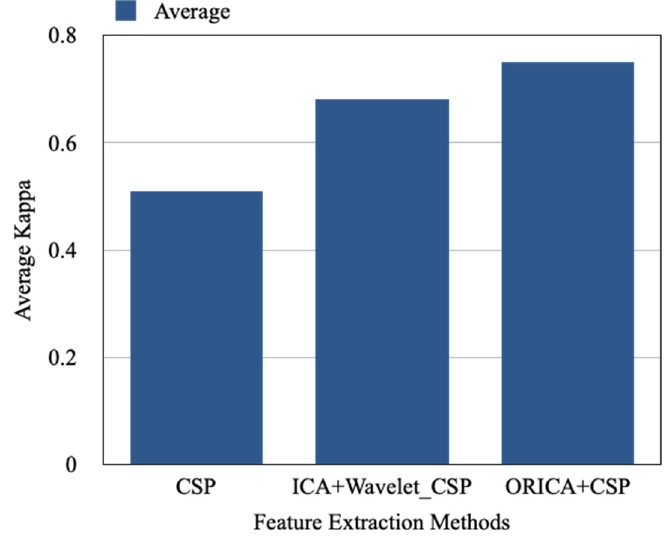
Figure 9. Comparison of average kappa value with CSP, ICA + Wavelet-CSP, and ORICA + CSP. Table 2. Performance comparison of every participant in terms of Cohen’s Kappa coefficient.